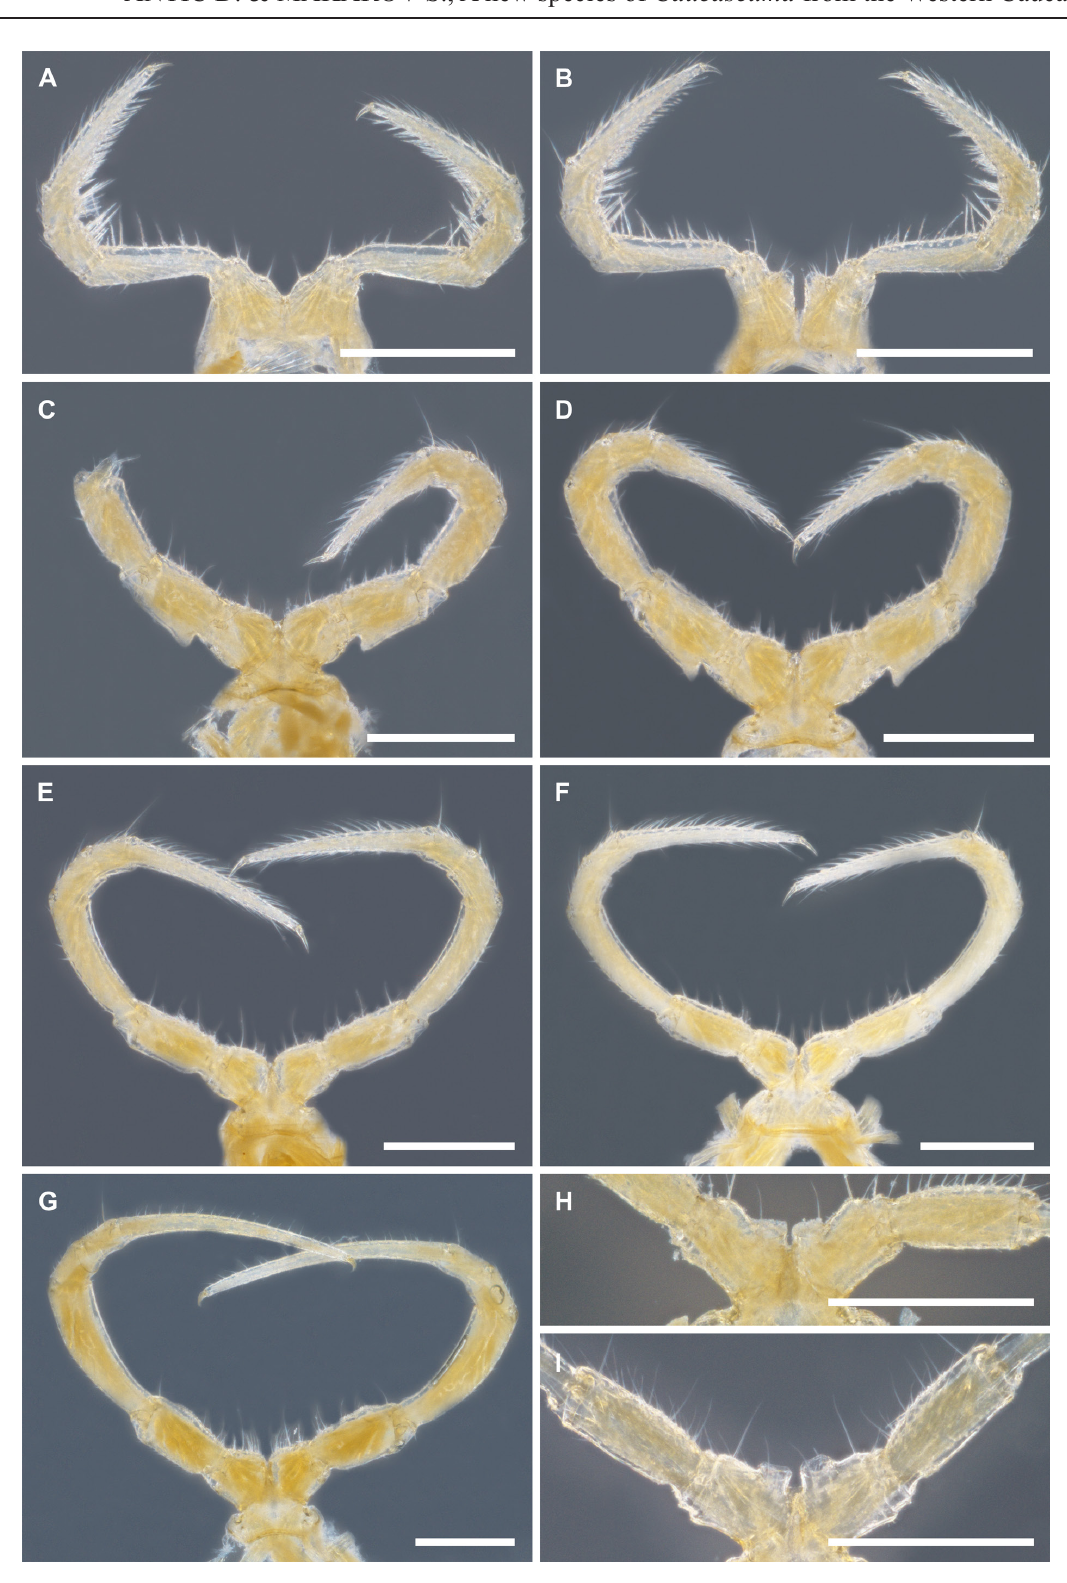
Fig. 4. Caucaseuma strasseri Antić sp. nov., paratype, ♂ (IZB). Legs in anterior view. A . Leg-pair 1. B . Leg-pair 2. C . Leg-pair 3. D . Leg-pair 4. E . Leg-pair 5. F . Leg-pair 6. G . Leg-pair 7. H . Leg-pair 10. I . Leg-pair 11. Scale bars = 0.5